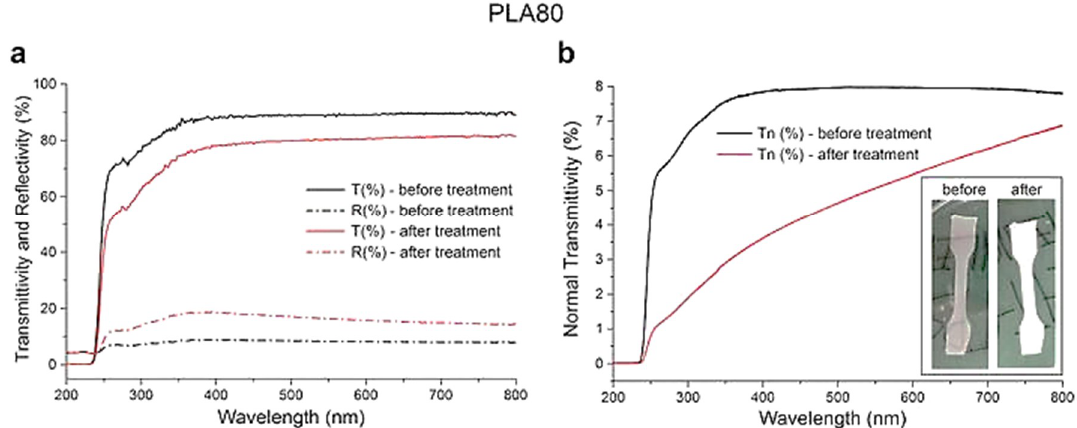
Figure 6. Spectral characterization of the PLA80 film: ( a ) total transmittances (solid lines) and the total reflectances (dash-dotted lines) measured before (black lines) and after (red lines) the treatment. ( b ) Normal transmittance measured before (black line) and after (red line) the treatment. In the inset, images of the PLA80 film before and after the treatment are shown.